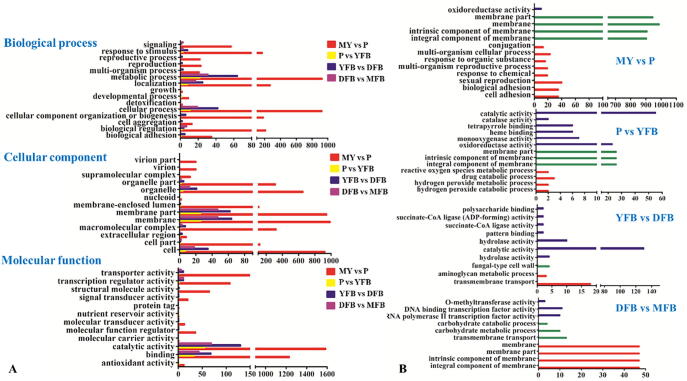
GO functional classification of DEGs in each of the four comparisons of two adjacent development stages. A, Gene ontology term assignments for the DEGs. B, The most enriched GO terms. The red lines represent biological process. The green lines represent cellular component. The blue lines represent molecular function. Only the most significant GO terms with P values < 0.005 were shown. My, Mycelial stage; P, Primordial stage; YFB, Young fruiting body stage; DFB, Developmental fruiting body stage; MFB, Mature fruiting body stage; vs, Versus. (For interpretation of the references to colour in this figure legend, the reader is referred to the web version of this article.)